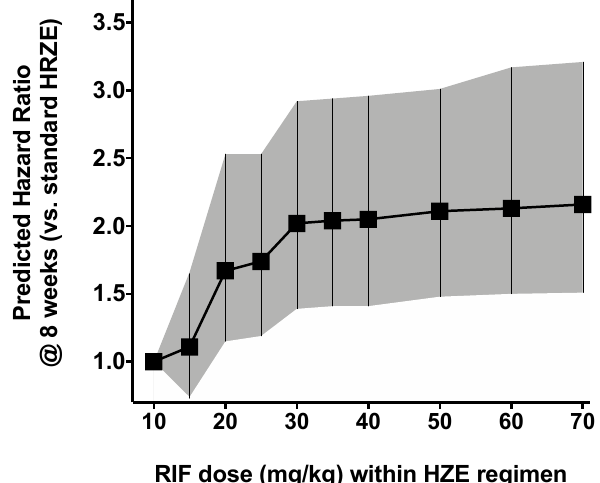
Figure 3. Predicted hazard ratio for di ff erent RIF dosing levels: 10 mg / kg up to 70 mg / kg (RIF 70 HZE) compared with the standard HRZE treatment. The hazard ratio was calculated over a period of eight weeks for each dosing level. Black squares are calculated hazard ratios and the grey shaded area is the confidence interval.